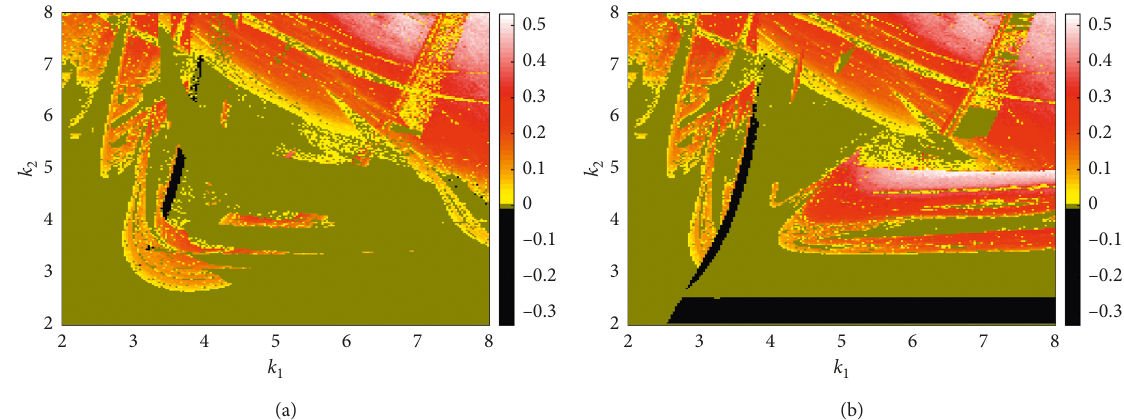
Figure 5: Two-dimensional dynamical maps in the k 1 - k 2 parameter plane by evaluating the values of the largest Lyapunov exponent under two sets of initial values. (a) Initial values (10 − 6 , 0, 0). (b) Initial values (10 − 6 , 3,